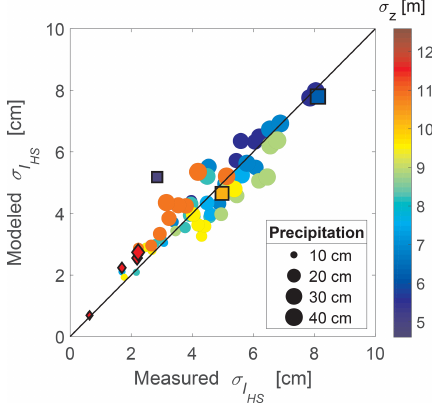
all MAE ≤ 0.63 cm), strong correlations (all r ≥ 0 . 92), and